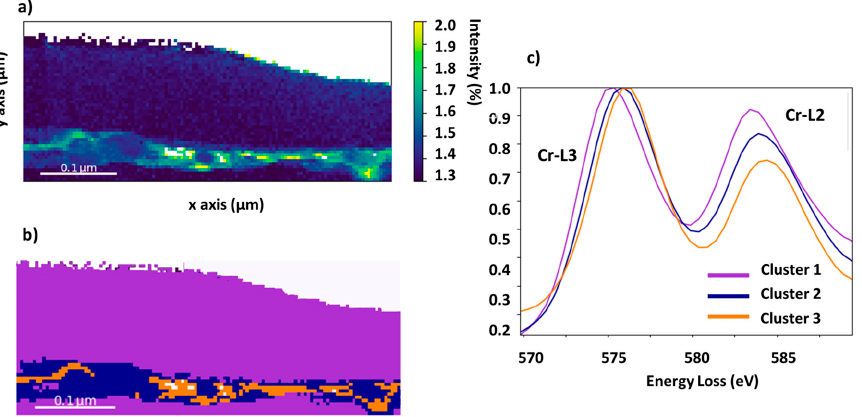
Figure 7. ( a ) Cr-L 3 /L 2 ratio intensity map. ( b ) K-means cluster map using the Cr-L 2,3 edges and ( c ) the corresponding EELS signals associated with each cluster.